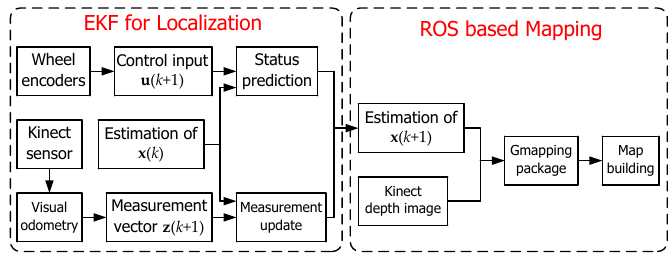
Figure 10. Flow chart of the mobile robot localization and mapping.